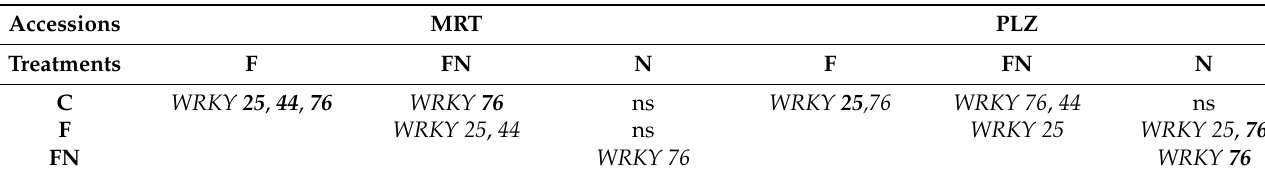
Table 2. Double entry table reporting significant up- (bold) or downregulated WRKY genes be- tween the different treatments (N = inoculated with M. incognita MILEV-L4; FN = inoculated with P. chlamydosporia DSM 26985 and MILEV-L4; F = inoculated with DSM 26985 and C = un- inoculated, control plants) for the two tomato accessions (MRT and PLZ). LSD Fisher test, p ≤ 0.05, ns = not significant.